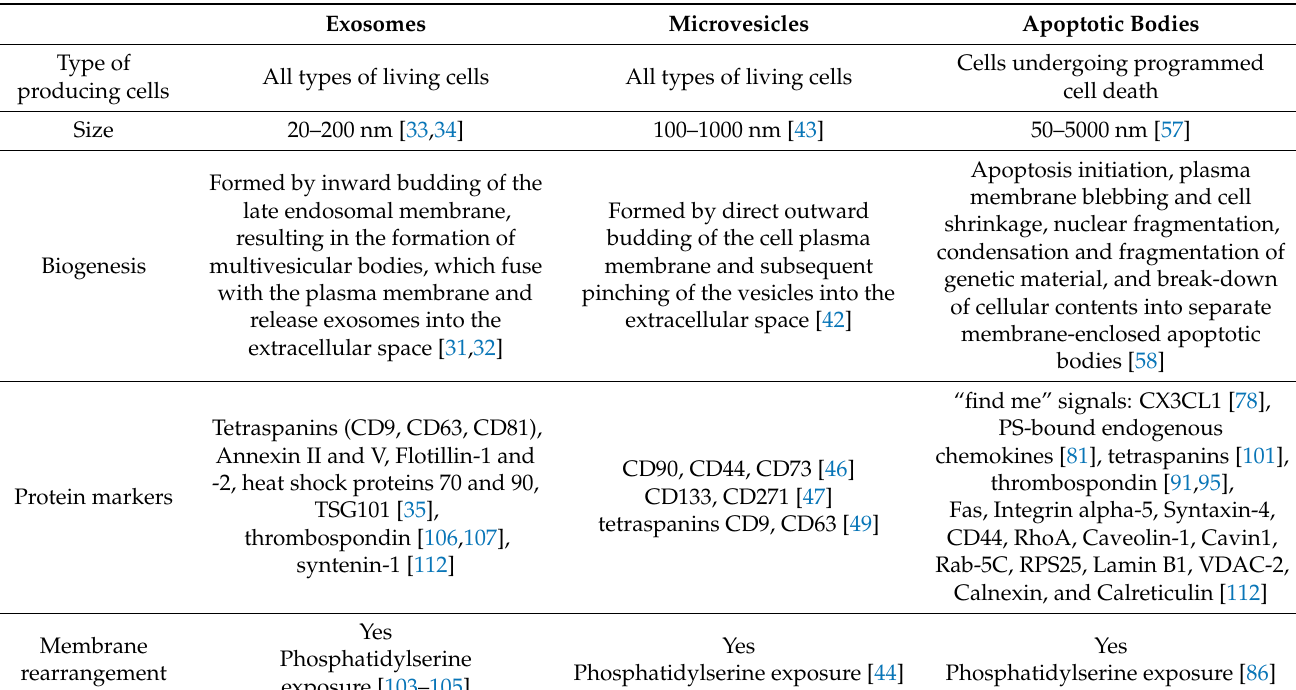
Table 1. The main characteristics of different types of